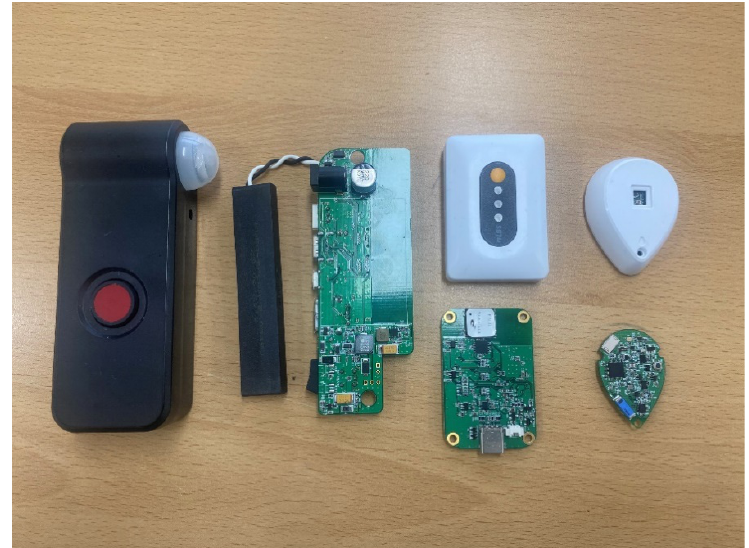
Figure 3. Implementation of Resource Device.